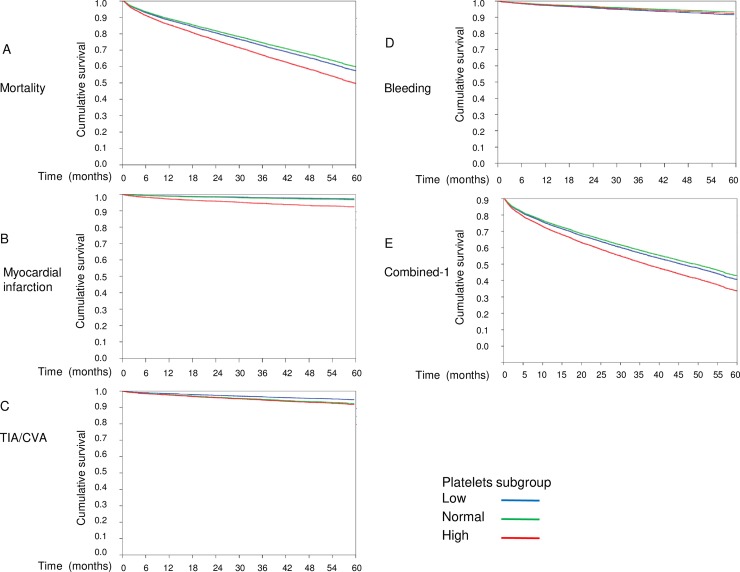
Kaplan-Meier curves for clinical endpoints in patients with low, normal and high platelet (PLT) count.(A) Overall survival. Patients with high PLT (red line) had significantly higher mortality rate during follow up. (B) Myocardial infarction free survival. Patients with high PLT had significantly higher rates of myocardial infarction during follow up. (C) Transient ischemic attack/ cerebrovascular accident (TIA/CVA) free survival. Patients with low PLT (blue line) compared to patients with normal PLT had significantly lower rates of TIA/CVA. (D) Bleeding free survival. No significant difference in bleeding episodes was seen between the 3 groups. A tendency for higher bleeding rate was seen in patients with low compared to normal PLT. (E) Combined-1 free survival. The rate of the combined-1 outcome that included mortality, MI, TIA/CVA, systemic emboli and bleeding was significantly higher among patients with high PLT.